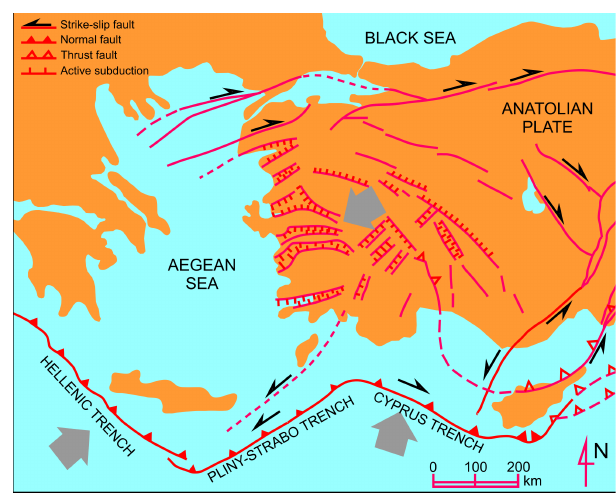
Fig. 1. Major tectonic structures in West Turkey (modified from Kocyigit,